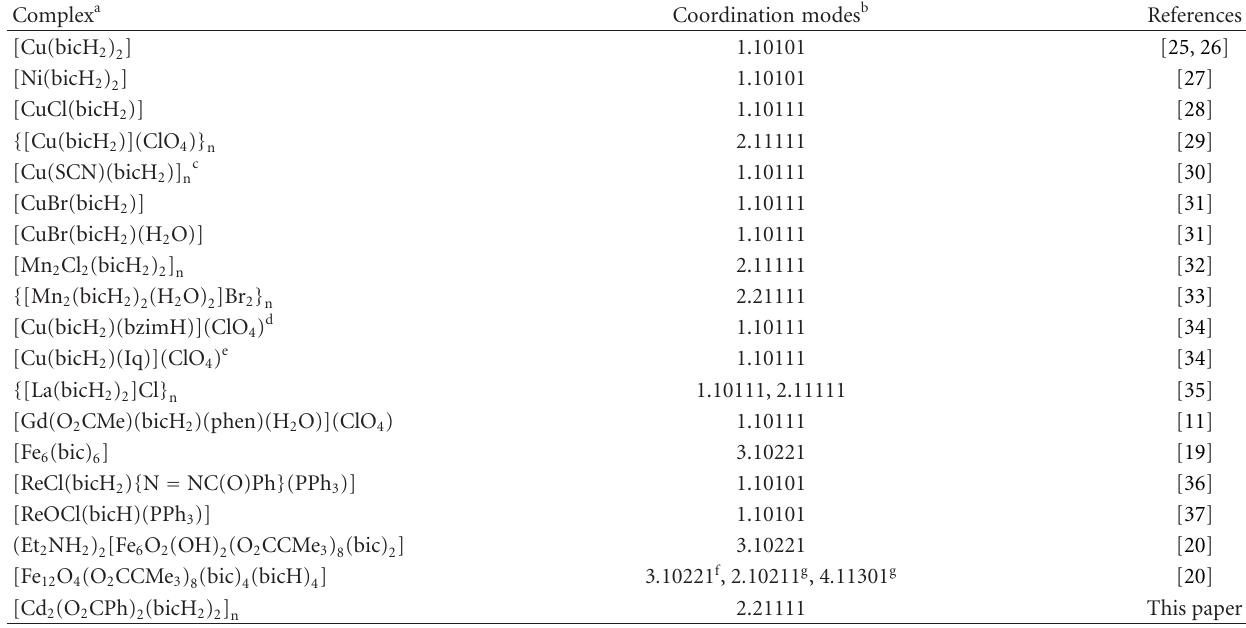
Table 4: Formulae and coordination modes of the bicinate( − 1, − 2, − 3) groups of the structurally characterized metal complexes containing various forms of bicine as ligands.